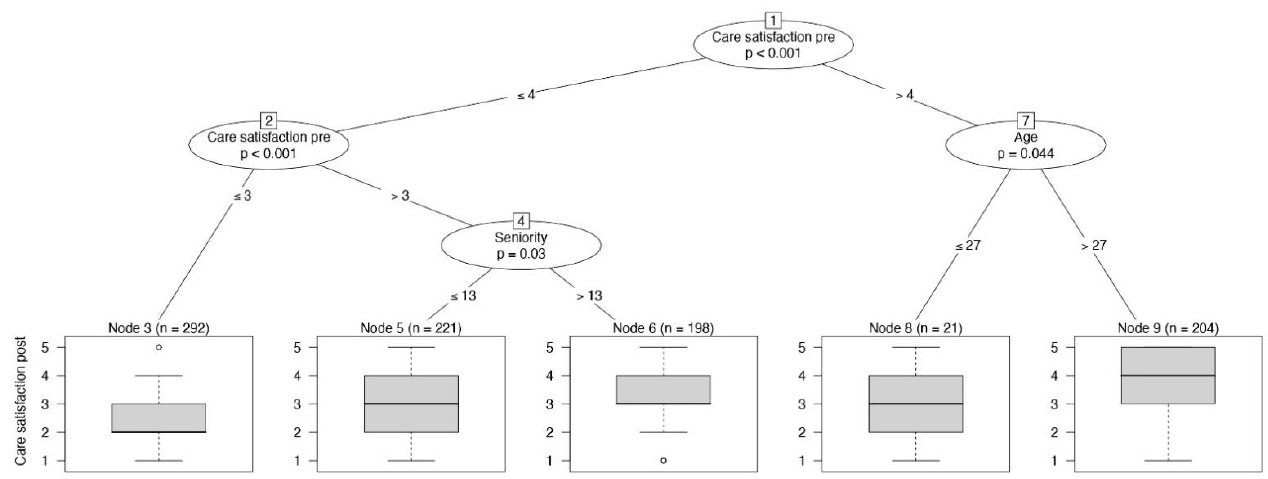
Figure 6. The conditional inference tree with the RNs’ satisfaction with the care provided as dependent variable, reported the bottom of the figure as at the bottom of the figure as boxplot.